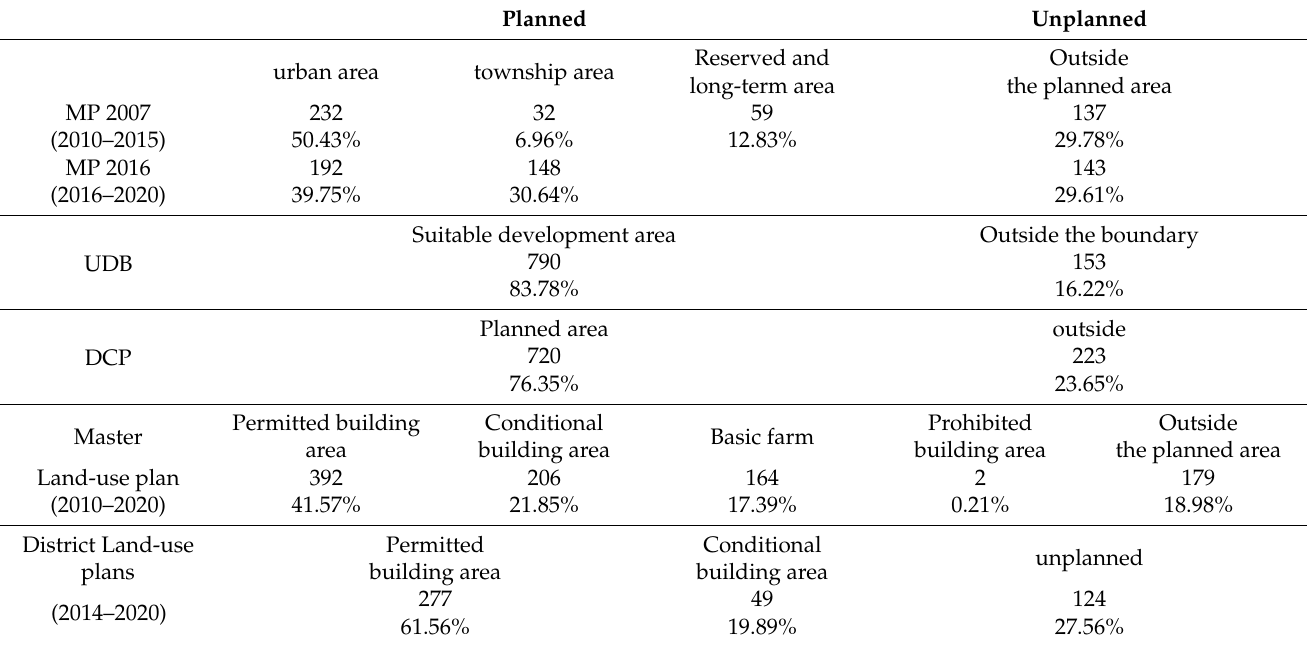
Table 2. Conformance between the urban planning and projects on administratively allocated land.